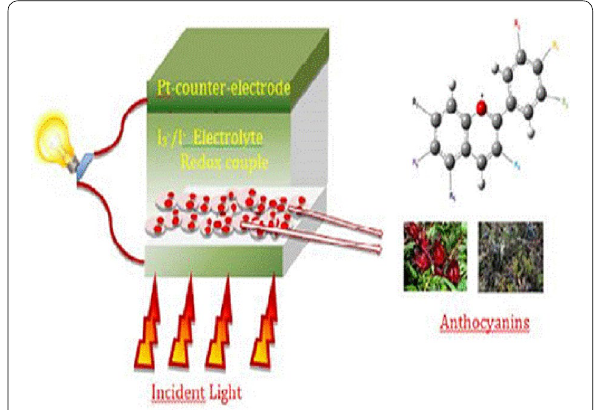
Scheme 1 Graphical abstract of dyes sensitized solar